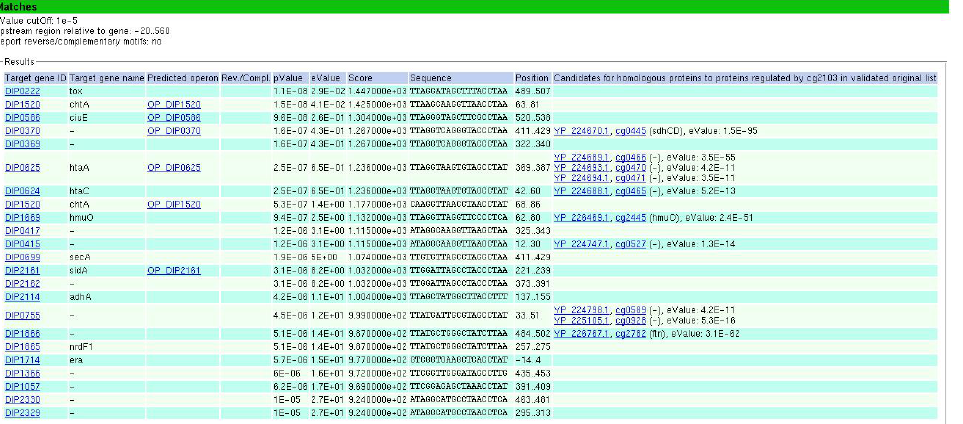
Figure 3: Results of a search of transcription factor binding sites with the integrated PoSSuM- search tool; see Section 5 for